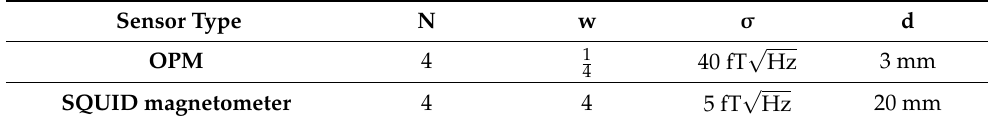
Table 1. Sensor models used in the present study. N is the number of integration points, w is the weight, σ is the noise level, and d is the sensor-scalp distance.